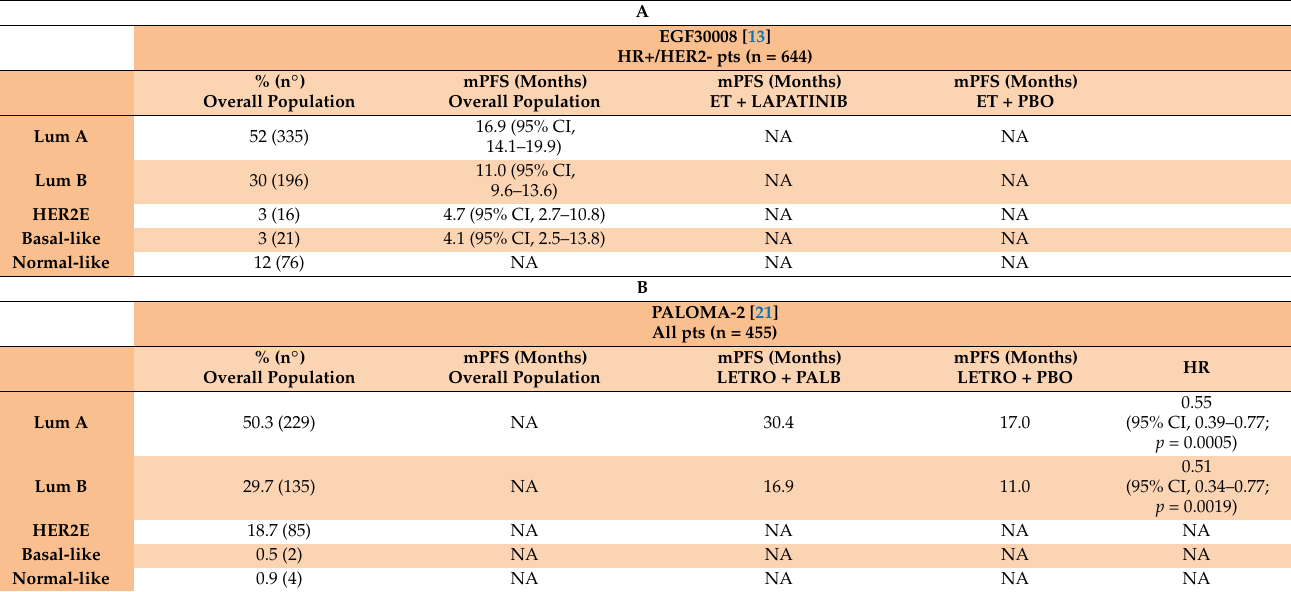
Table 1. Distribution and outcome by intrinsic subtype in pts from ( A ) EGF30008 trial; ( B ) PALOMA-2 trial; ( C ) BOLERO-2 trial; ( D ) PALOMA-3 trial; ( E , F ) MONALEESA trial. EXE: exemestane;